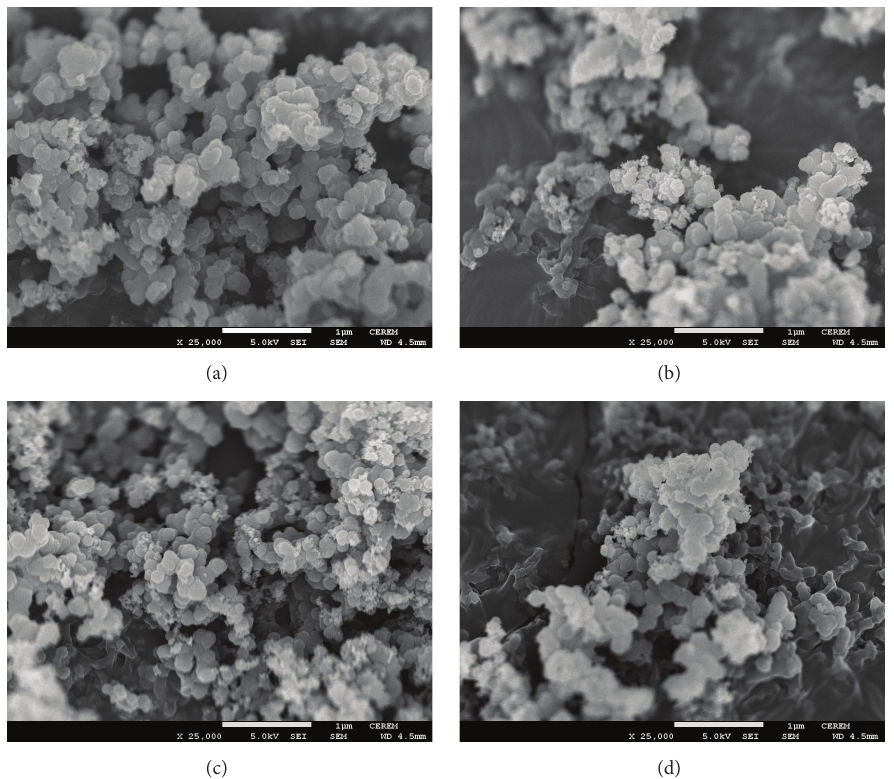
Figure 4: SEM micrographs of (a) 2wt% Ppy/TiO 2 , (b) 3wt% Ppy/TiO 2 , (c) 4 wt% Ppy/TiO 2 , and (d) 5wt% Ppy/TiO 2 composites.